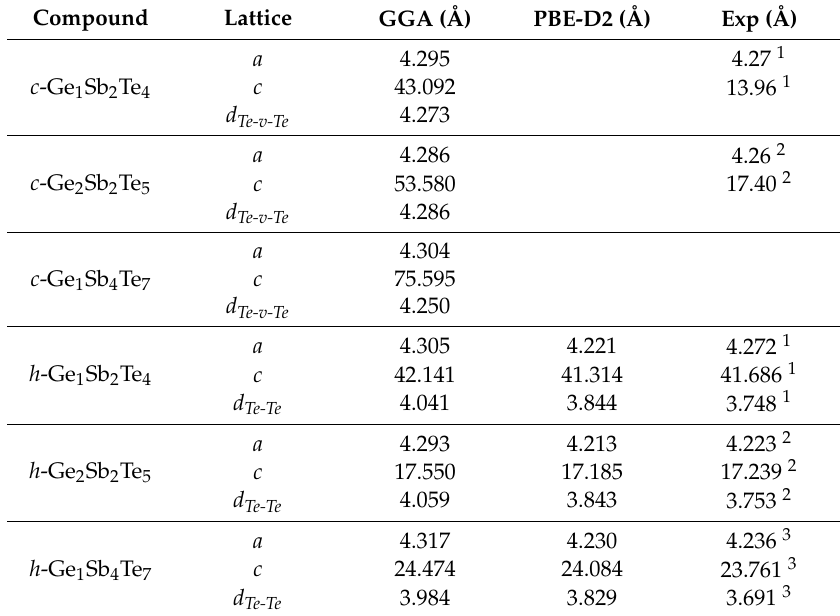
Table 1. Calculated lattice parameters of meta-stable rock-salt like and hexagonal m GeTe • n Sb 2 Te 3 chalcogenides. Exp refers to experimental data from